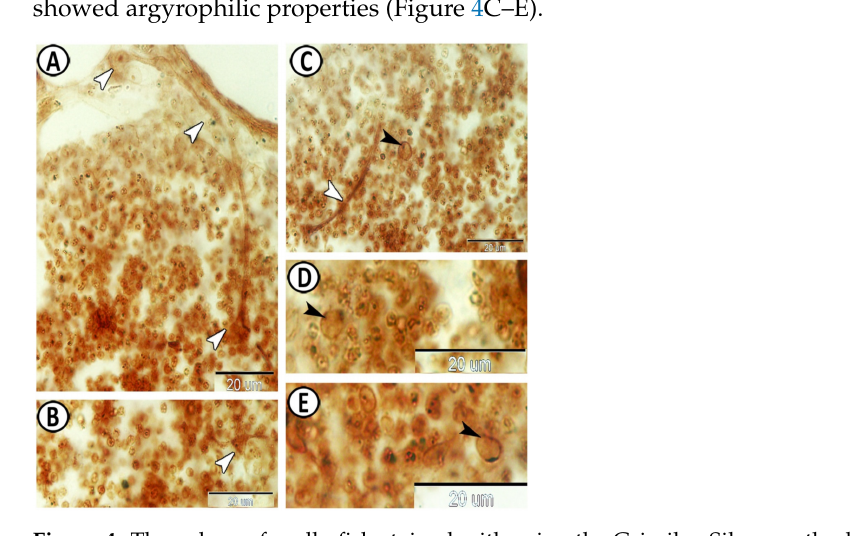
Figure 4. The spleen of molly fish stained with using the Grimilus Silver method. ( A ) The spleen was innervated by sympathetic nerve fibers (arrowheads). ( B ) A single adrenergic neuron (arrow- head) was found in the splenic parenchyma. ( C – E ) Rodlet cells (black arrowheads) were randomly distributed in the spleen. Note the nerve fiber (white arrowhead) among the splenic cells.